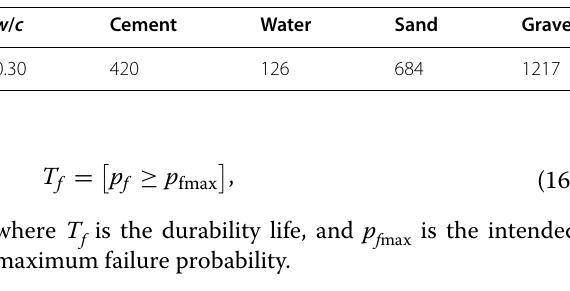
Table 1 Mixture proportions of concrete (kg/m 3